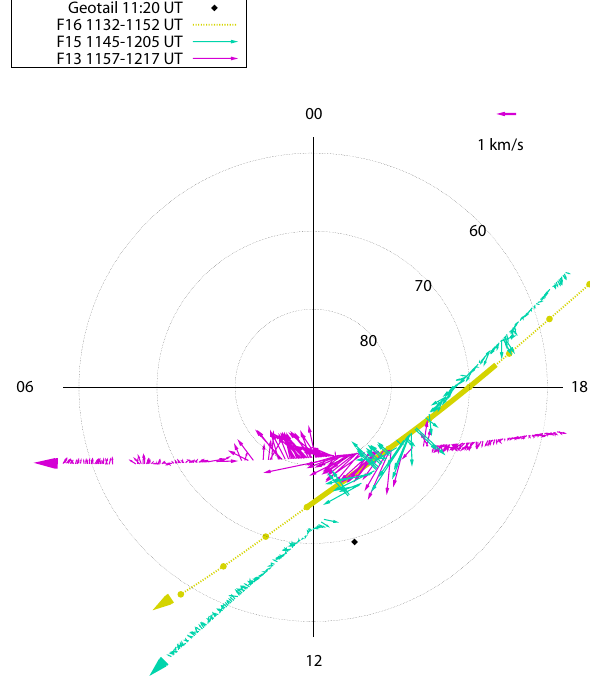
Fig. 6. Orbits of the DMSP satellites and observed flows. They moved from the dusk sector to the morning sector. Magnetic local time and latitude are displayed. The top (bottom) is the midnight (noon), and the left (right) is the dawn (dusk). The thick solid line in the F16 track indicates the polar cap region derived from the pre- cipitation signature. The mapped position of Geotail at 11:20 UT is also shown.